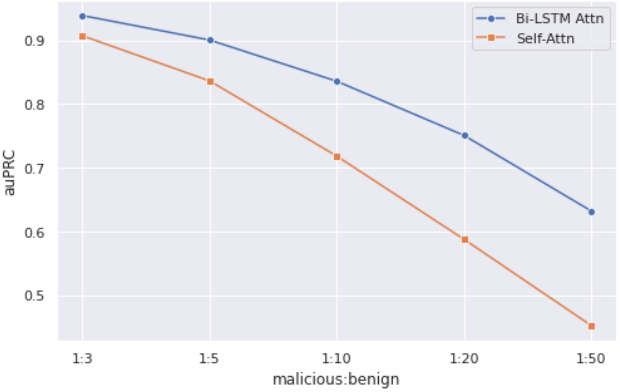
Figure 10. Experimenting with varying malware apps to benign apps ratio in the test